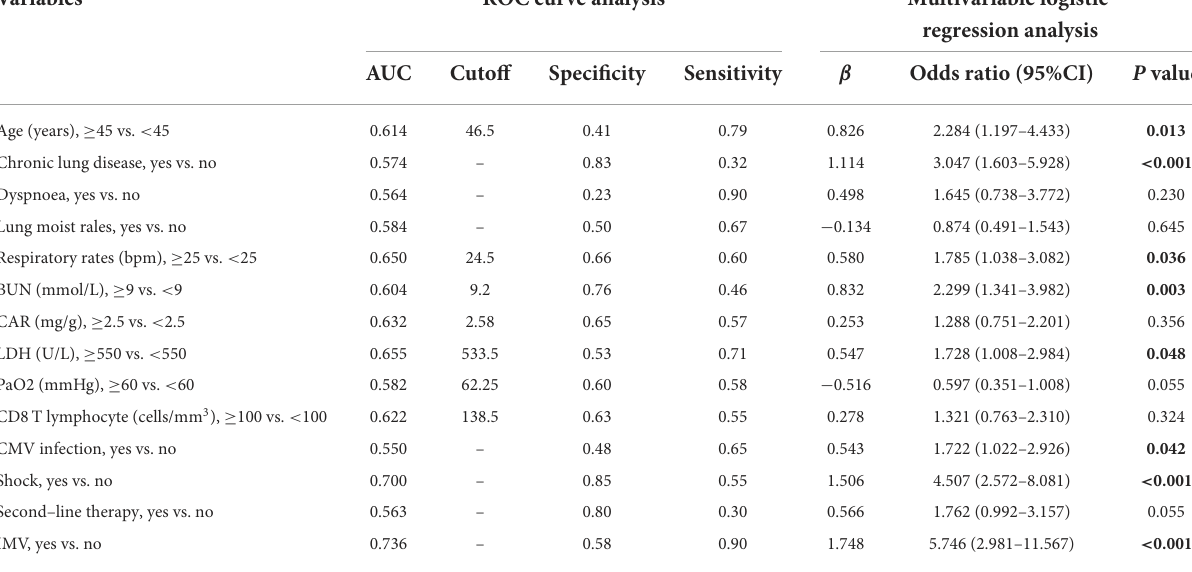
TABLE 4 ROC curve analysis and multivariable logistic regression analysis in selected factors of death of patients with PCP identified by LASSO regression.